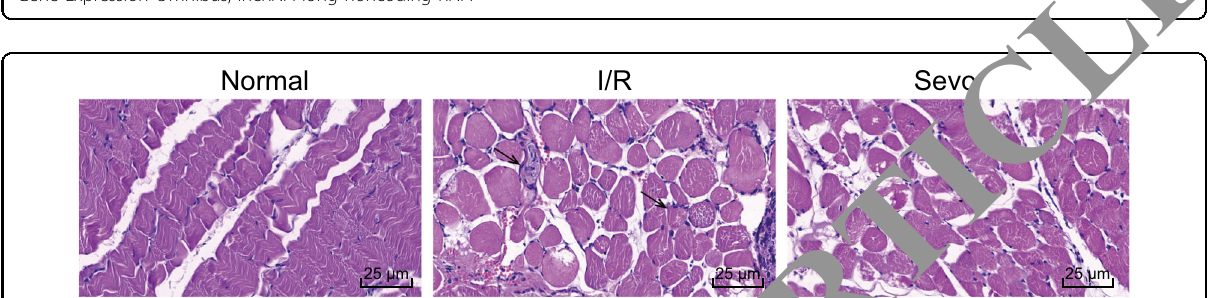
Fig. 2 Images of skeletal muscle tissues of mice after hematoxylin – eosin staining in the normal, I/R, and Sevo groups (×400). I/R ischemia- reperfusion, Sevo sevo fl urane; the arrows point to the in fi ltration of in fl ammatory cells; scale bar = 25 µm; the experiment was repeated 3